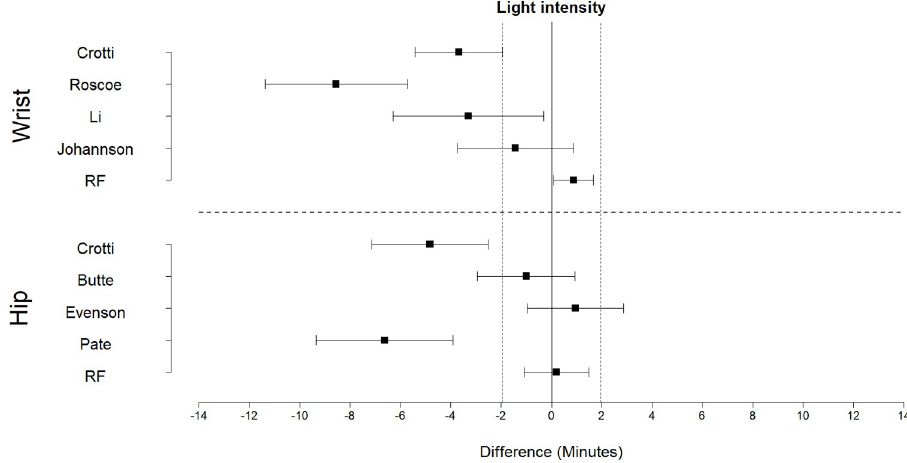
Fig 5. Equivalence plots for hip and wrist models for light-intensity activity during the free play session. Difference = predicted time—observed time; Equivalence bounds = ± 1.9 min.